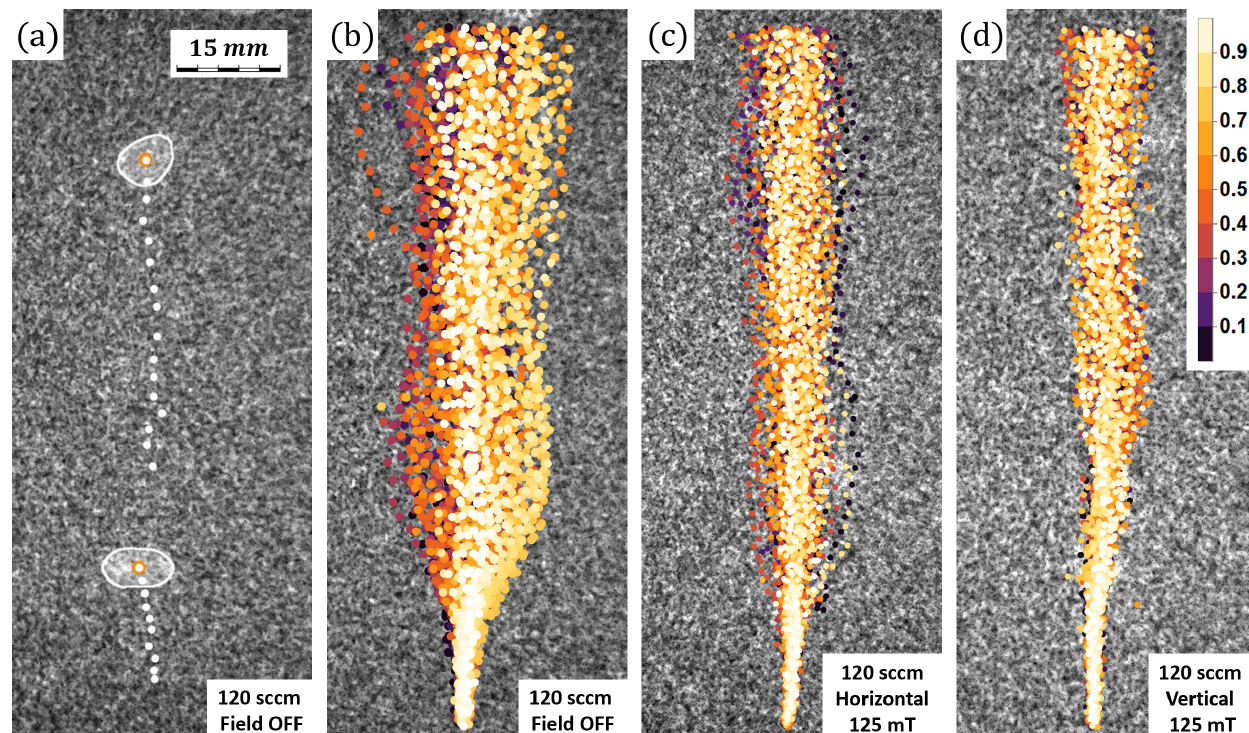
Figure 17. The locations of bubbles detected in the FOV for a sequence of 3000 images (30 s) at a 120 sccm flow rate for the new model system (Section 2.1, vertical inlet): ( a ) an example of detected bubbles: white contours are shapes, orange dots are the current positions and white dots are the preceding detections; ( b – d ) all detected bubble positions with ( b ) no applied MF, ( c ) horizontal ∼ 125 mT MF and ( d ) vertical ∼ 125 mT MF. Bubble locations in ( b – d ) are marked as in Figure 14. All sub-figures are to